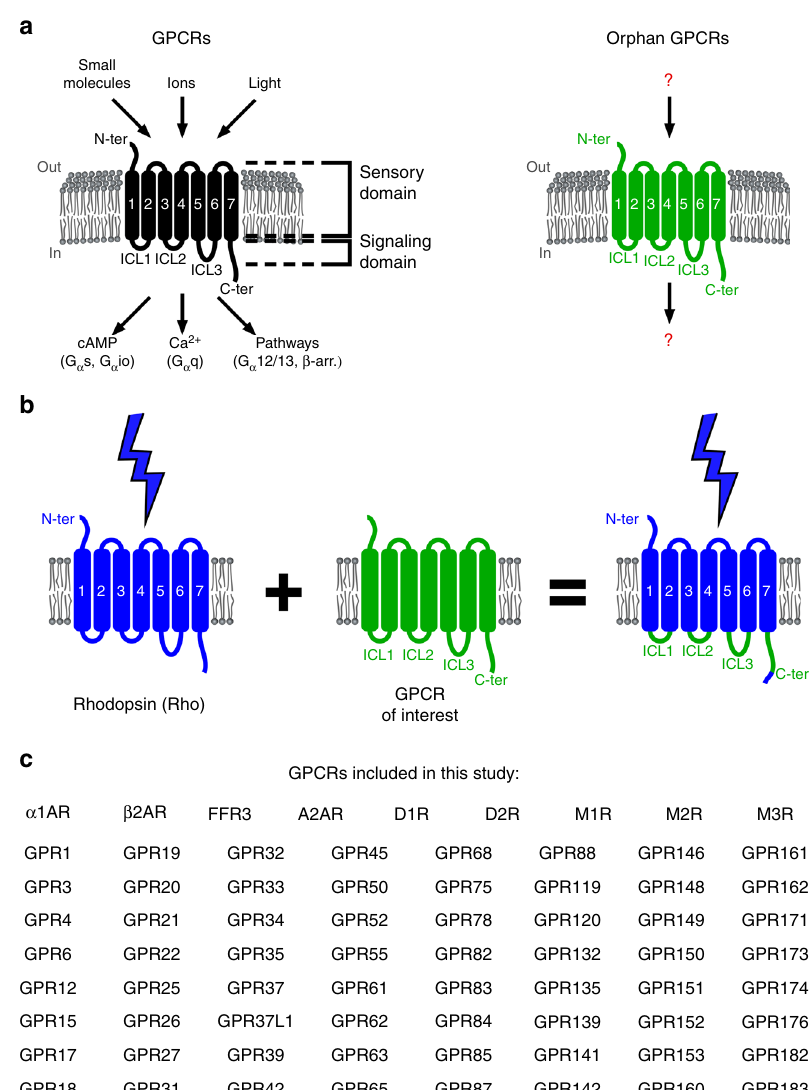
Fig. 1 Light-activated human orphan and understudied GPCRs. a In Class A GPCRs, extracellular and transmembrane domains are responsible for ligand sensing, while intracellular domains couple with downstream signaling pathways. For orphan GPCRs, both the identity of ligands as well as of downstream signals remain unknown. b In domain swapping experiments, the intracellular elements of orphan and understudied GPCRs were grafted onto the light- activated GPCR rhodopsin, yielding light-activated, chimeric GPCRs. c Reference GPCRs and orphan and understudied GPCRs included in